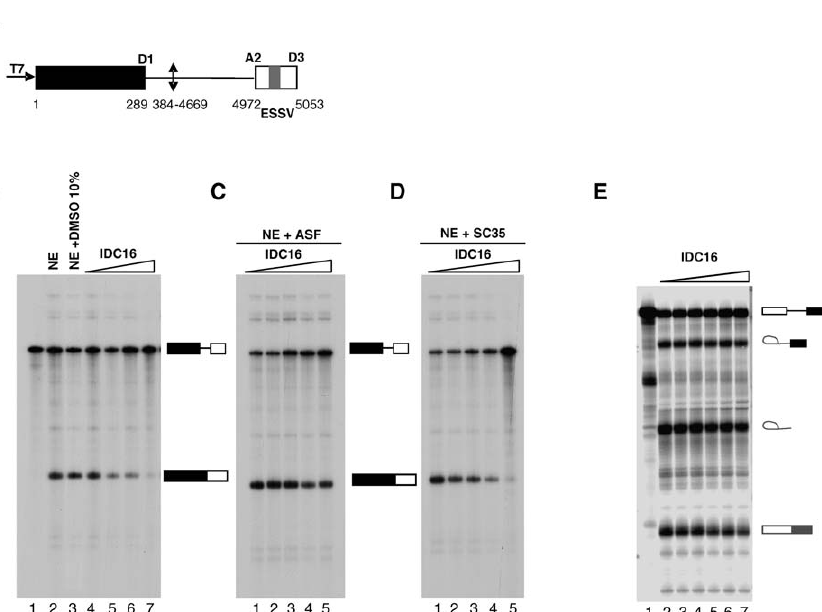
Figure 2. In Vitro Inhibition of HIV1-D1-A2 pre-mRNA Splicing by IDC16 and Complementation with SR Proteins SC35 and SF2/ASF (A) Schematic representation of HIV1-D1-A2 transcript is shown. Numbering of the HIV-1/BRU RNA sequences is according to Ratner et al. [49]. (B) Polyacrylamide gel electrophoresis of the in vitro splicing products of HIV1-D1-A2 transcript. Uniformly labeled RNA was prepared as described under Materials and Methods and was incubated alone (lane 1) in a HeLa cell nuclear extract under splicing conditions in the absence (lane 2), in the presence of 10% DMSO (lane 3), or 5 l M, 10 l M, 20 l M, and 40 l M of compound IDC16 (lanes 4–7, respectively). (C) The same reactions as in (B) lanes 3–7 were complemented with 0.21 l M of recombinant SF2/ASF (lanes 1–5, respectively). (D) The same reactions as in (B) lanes 3–7 were complemented with 0.19 l M of recombinant SC35 (lanes 1–5, respectively). (E) Splicing products of the Minx transcript analyzed by polyacrylamide gel electrophoresis. Uniformly labeled RNA was incubated alone (lane 1), in HeLa nuclear extract in the absence (lane 2) or presence of 5 l M, 10 l M, 20 l M, 30 l M, or 50 l M of compound IDC16 (lanes 3–7),